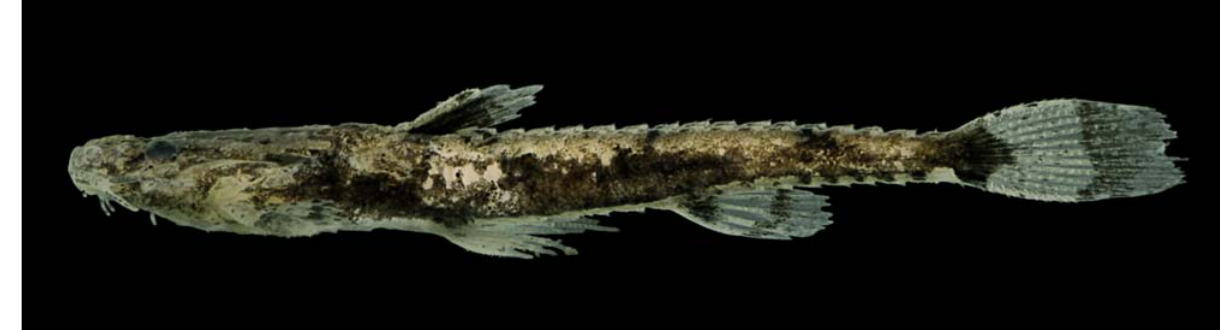
Fig. 1. Scoloplax baskini , INPA 28658, holotype, 14.4 mm SL. Photo by R. R. de